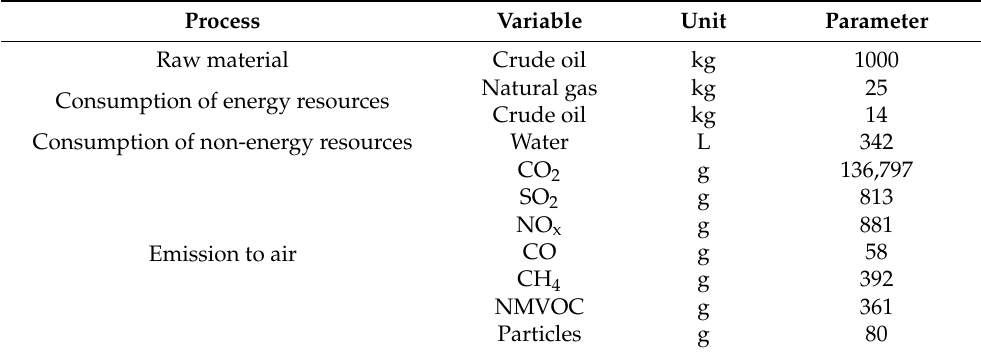
Table 3. Life Cycle Inventory to produce 1 ton of